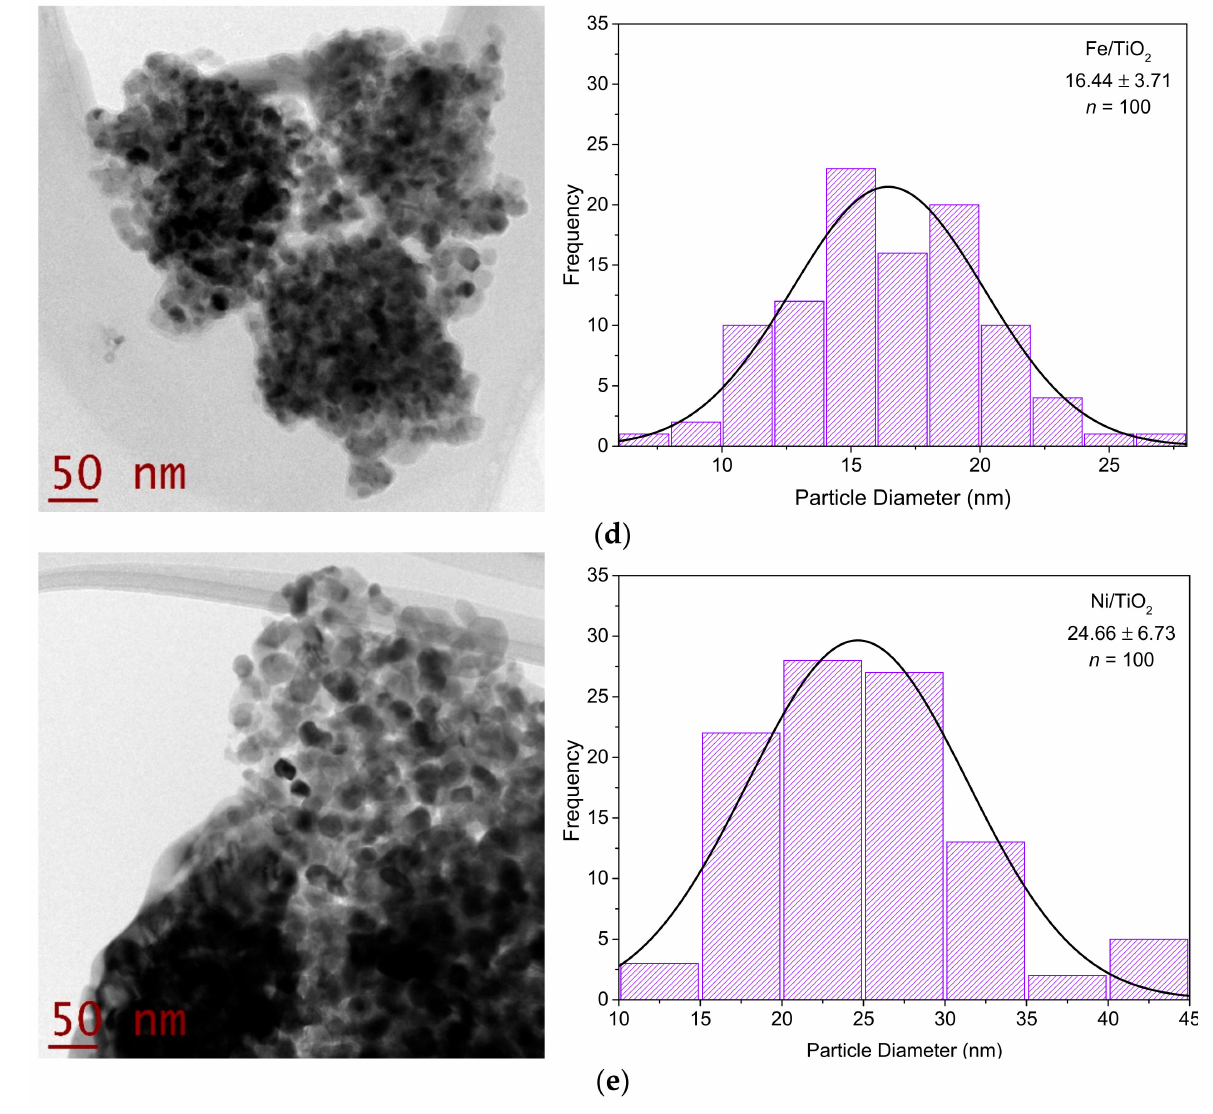
Figure 2. Transmission Electron Microscopy images and particle diameter of photocatalysts: ( a ) TiO 2 ;